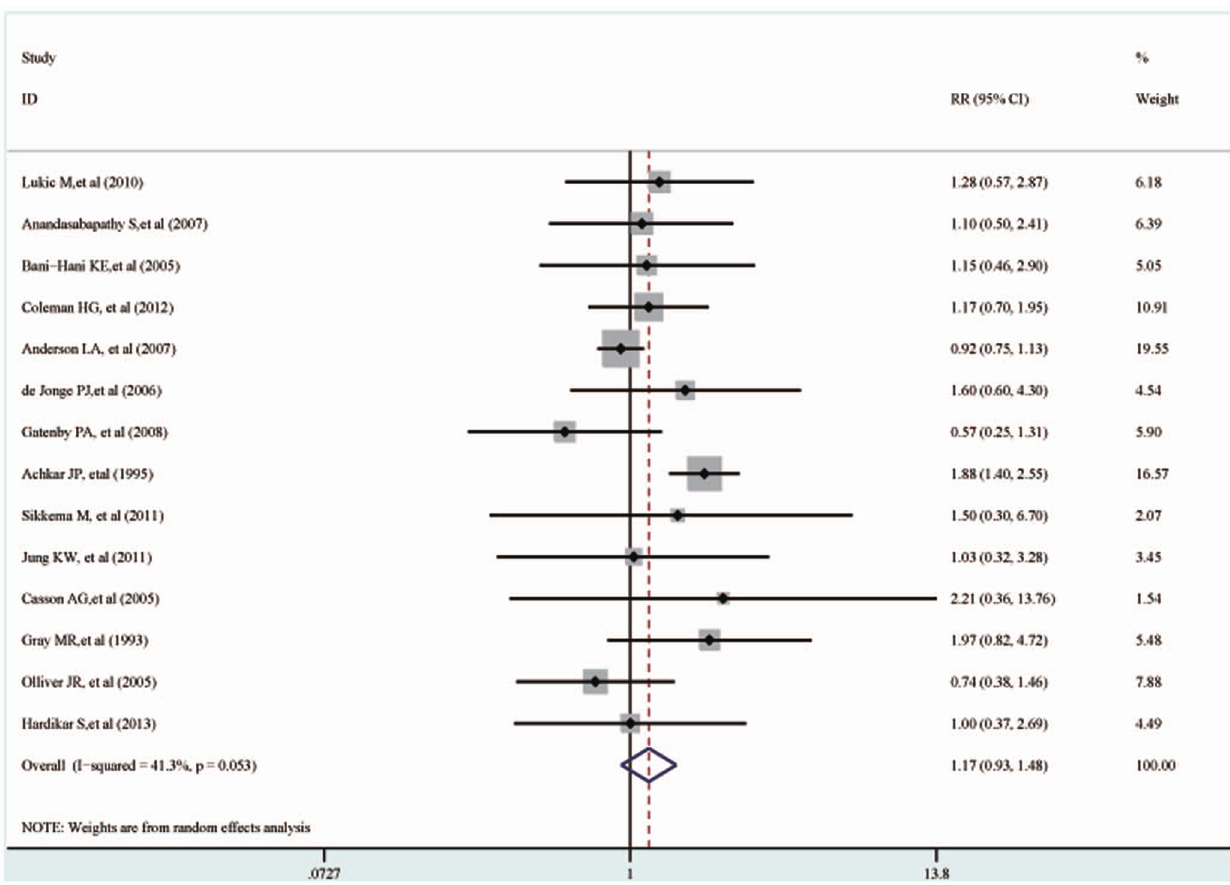
Figure 2. Forest plot of the association between alcohol drinking and risk of Barrett’s esophagus progressiom.